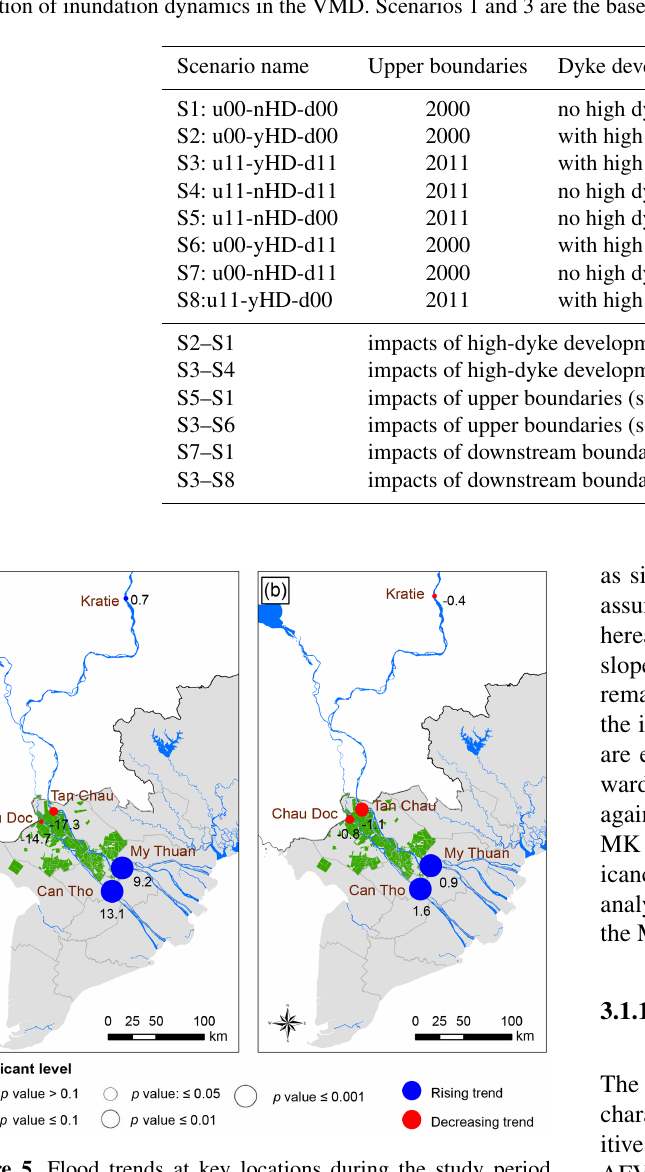
Figure 5. Flood trends at key locations during the study period 1978–2015. (a) Trend of annual maximum water level, slope pre- sented in mmyear − 1 . (b) Trend of duration of peak over threshold and annual flood volume, slope presented in day year − 1 (DOT) and in km 3 year − 1 (flood volume). Blue circles indicate rising trends and red circles imply decreasing trends. Circle size is proportional to significance level. The numbers present estimated slope. High- dyke areas are marked in